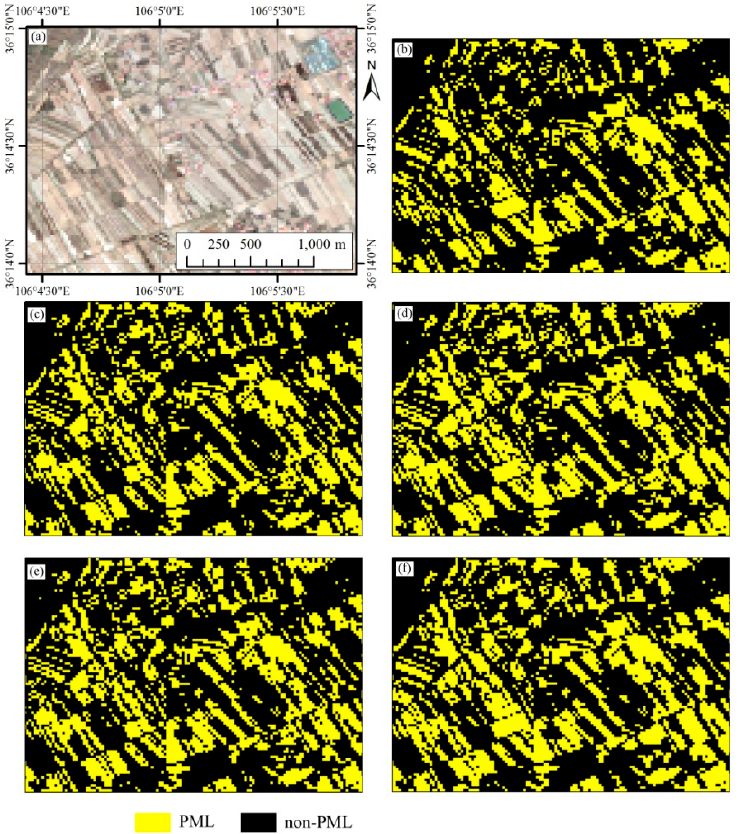
Figure 9. Visual comparison of PML mapping results in the first subset region of GY. ( a ) June 1–15 2018 composited Sentinel-2 image. ( b ) PML mapping results of PMLI using the MTPML workflow. ( c ) PML mapping results of PMLI_NIR using the MTPML workflow. ( d ) PML mapping results of PMLI_SWIR using the MTPML workflow. ( e ) PML mapping results of PMLI_ND using the MTPML workflow. ( f ) PML mapping results of RF using the MTPML workflow.